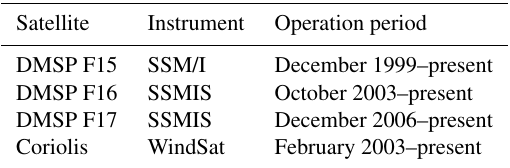
Table 1. Satellite instruments used in this study. Satellite Instrument Operation